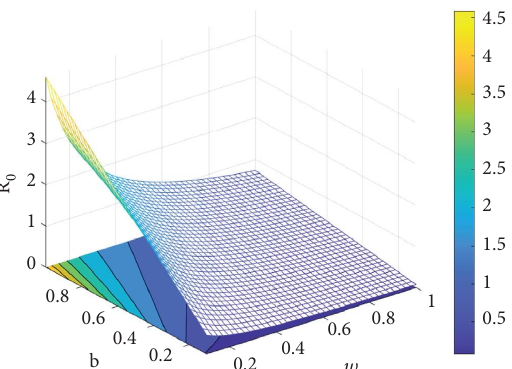
Figure 7: Te dynamics of sensitivity analysis with respect to parameters β and b with R